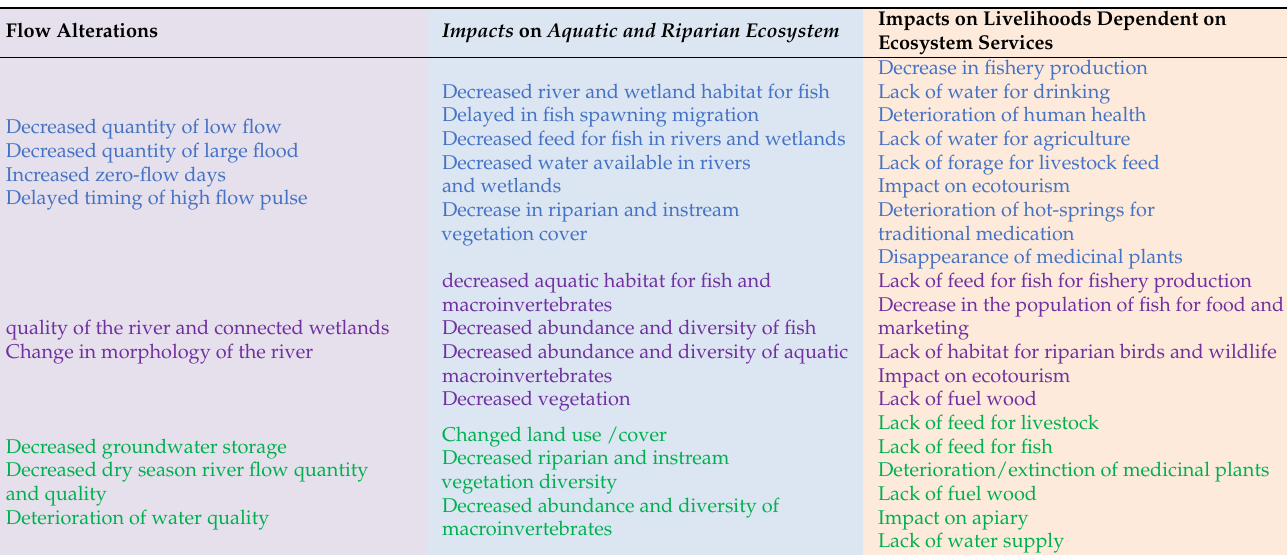
Table 2. Conceptual framework for flow–ecology–livelihood linkages * in the Gumara River and connected wetlands of the Lake Tana sub-basin. This is based on the findings of this study and Abebe et al.